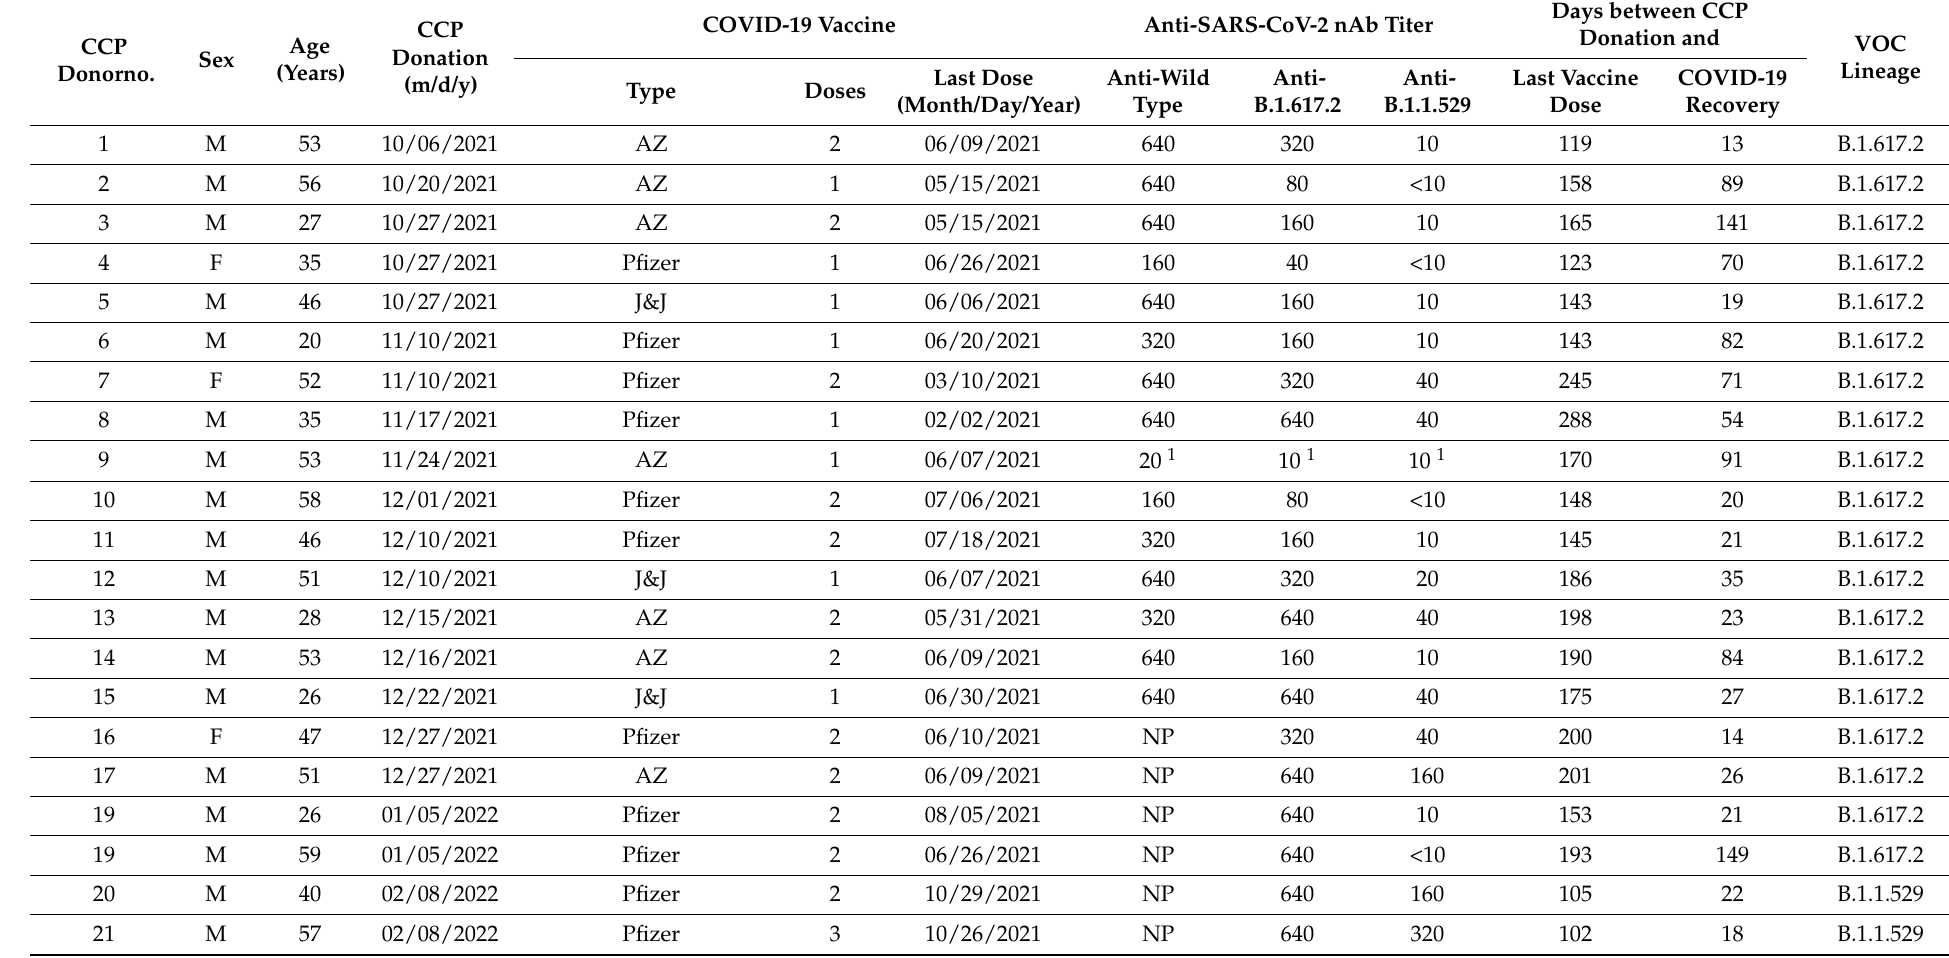
Table 1. Characteristics of the COVID-19 convalescent plasma